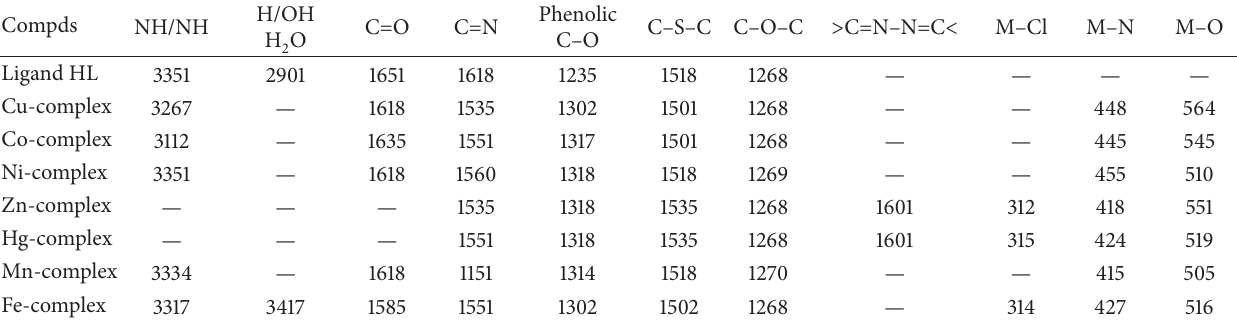
Table 2: The IR (in cm − 1 ) data of ligand HL and its complexes.